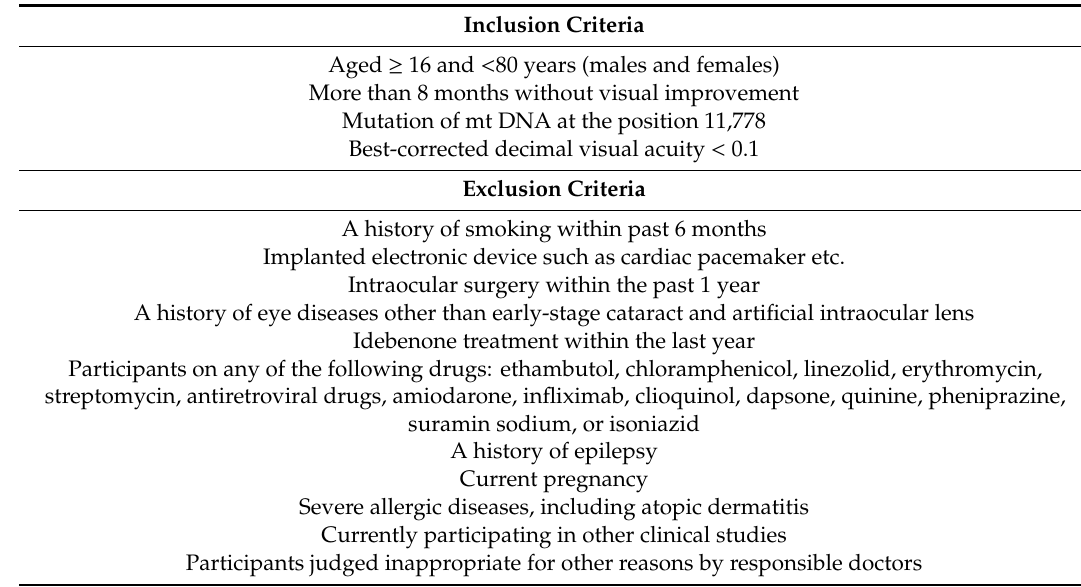
Table 1. Inclusion and exclusion criteria.